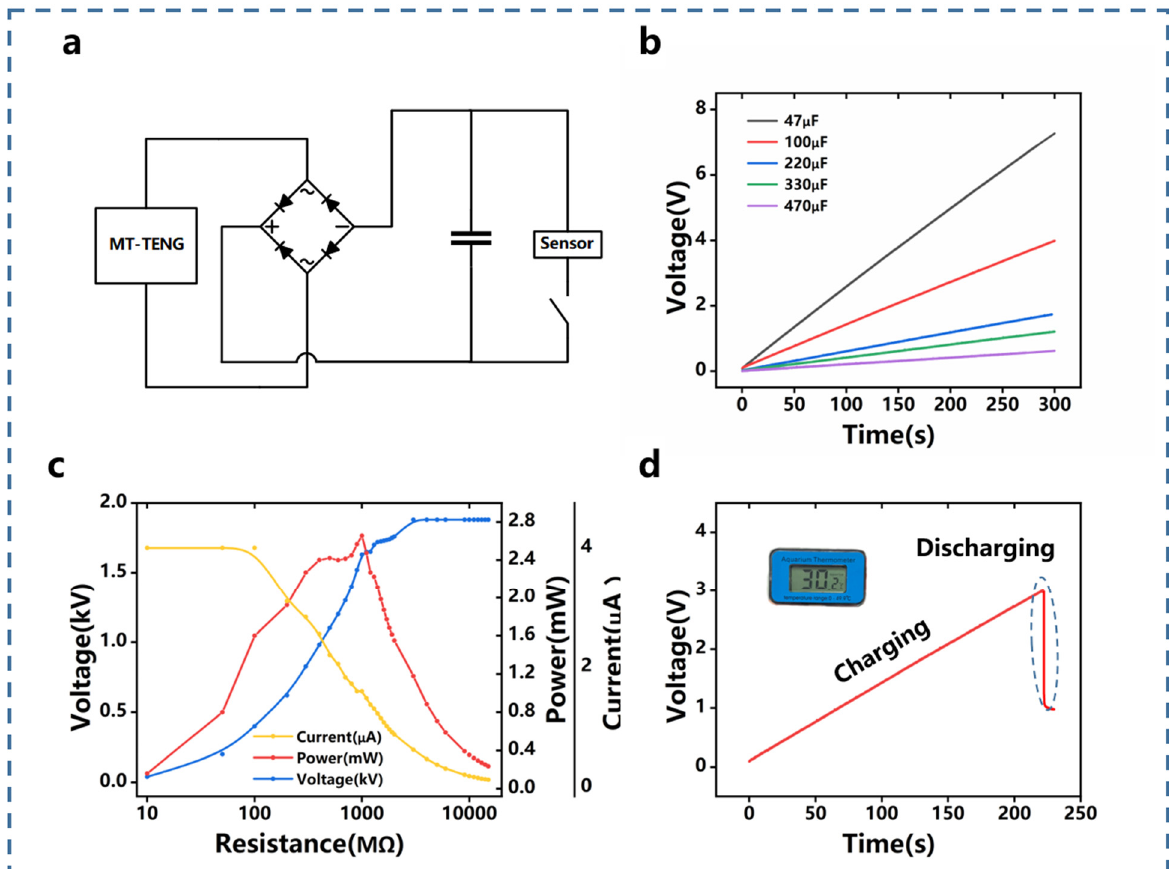
Figure 5. ( a ) The corresponding equivalent circuit of the MT-TENG used to power the sensor. ( b ) The diagram of the MT-TENG charging different capacitors. ( c ) The output voltage, current and output power for the MT-TENG (10-tunnel) on the resistance of the load. ( d ) Powering a thermometer with the MT-TENG.